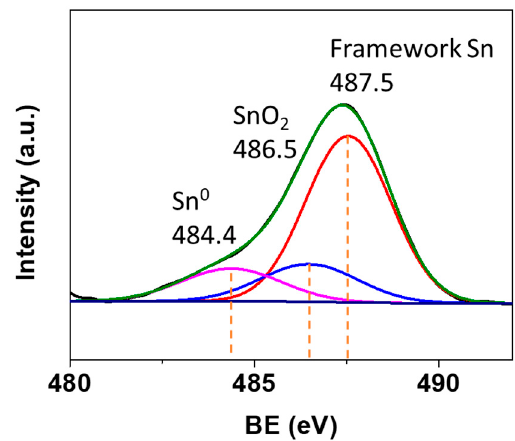
Figure 3. XPS spectrum of the 0.4 wt% Sn-Beta representing Sn 0 , SnO 2 , and Sn isomorphous substitution in the zeolite framework at 484.4, 486.5, and 487.5 eV, respectively.